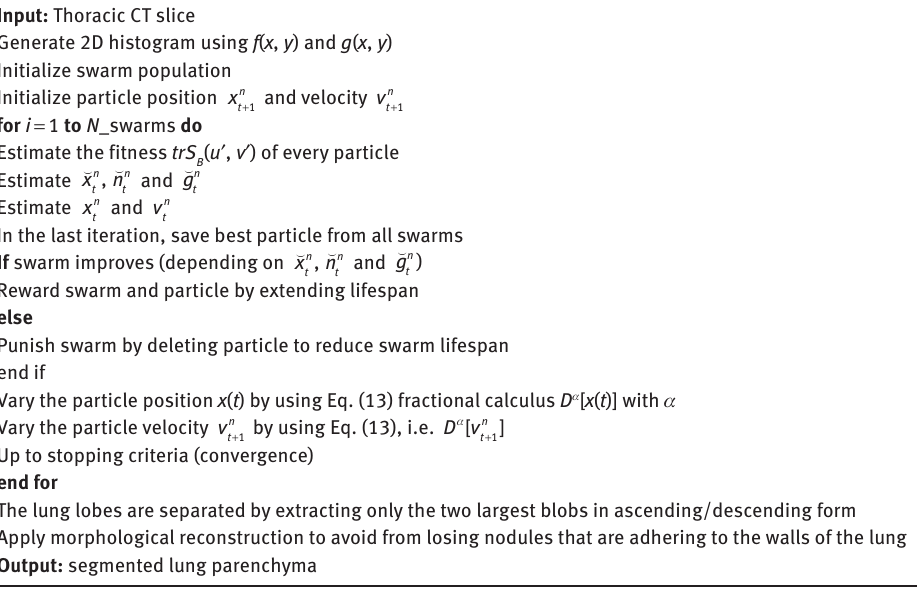
Table 3: Algorithm for Segmenting Lung Parenchyma in Thoracic CT Image by Using Fractional Calculus. Input: Thoracic CT